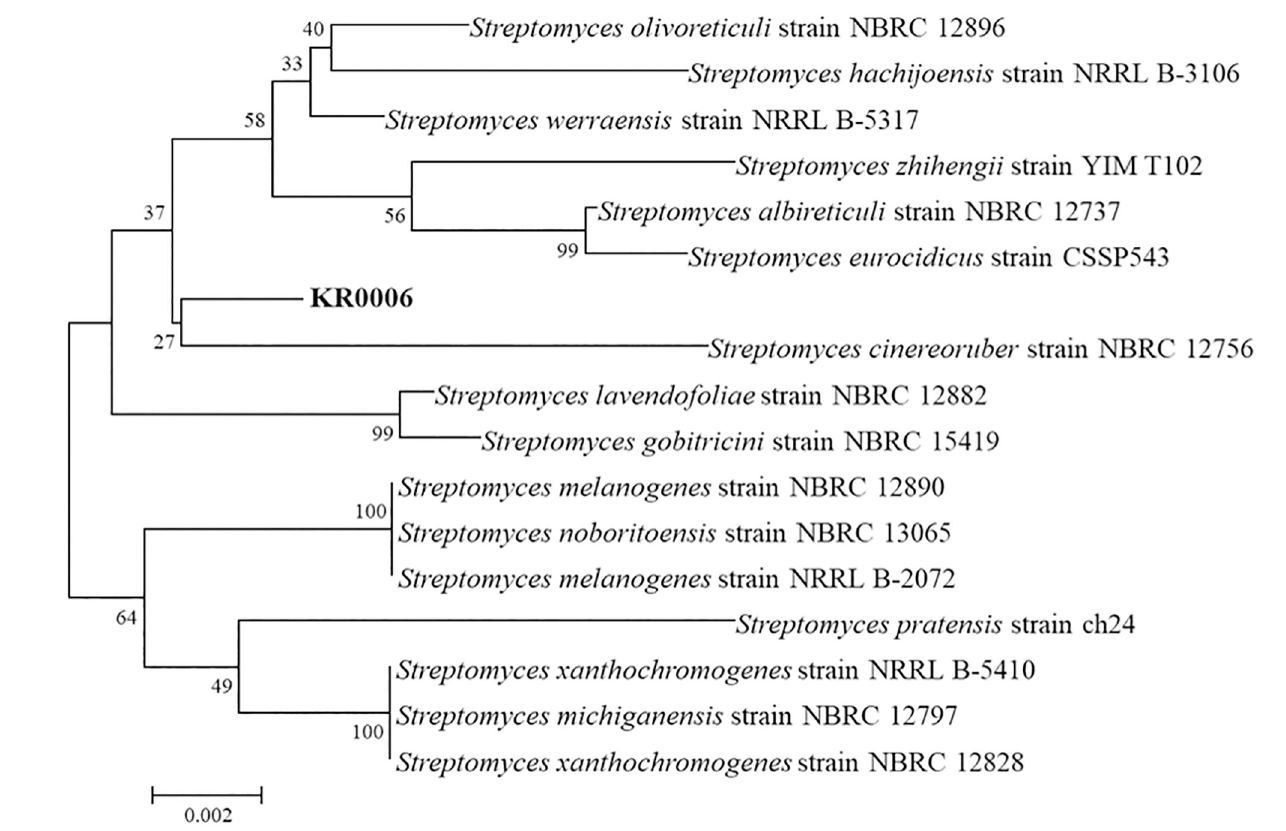
Fig 5. Neighbor-joining tree of strain KR0006 based on its 16S rRNA gene sequence showing the phylogenetic relationship with related Streptomyces species. Numbers at each branch node indicate the bootstrap percentage of 1000 replications.